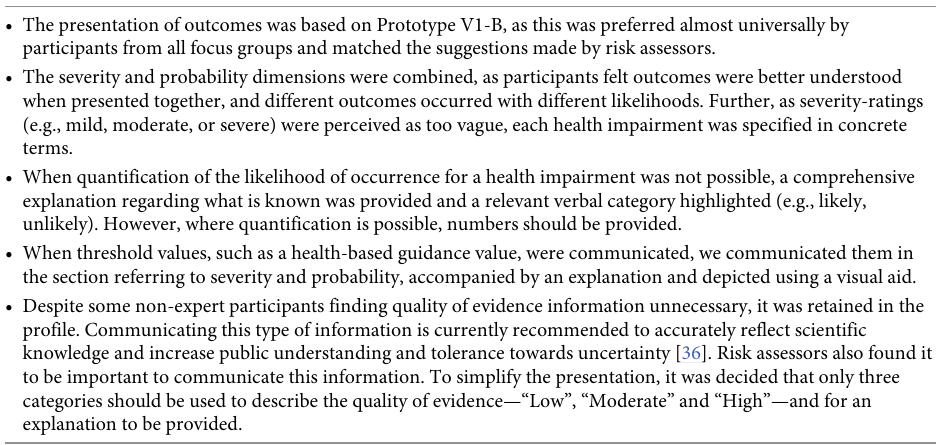
Table 3. Summary of changes to the initial prototype examples (V1) from focus groups with risk managers and general public.